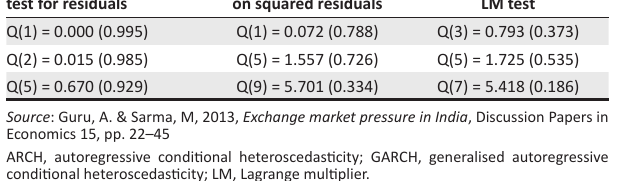
Weighted Ljung–Box test on squared residuals